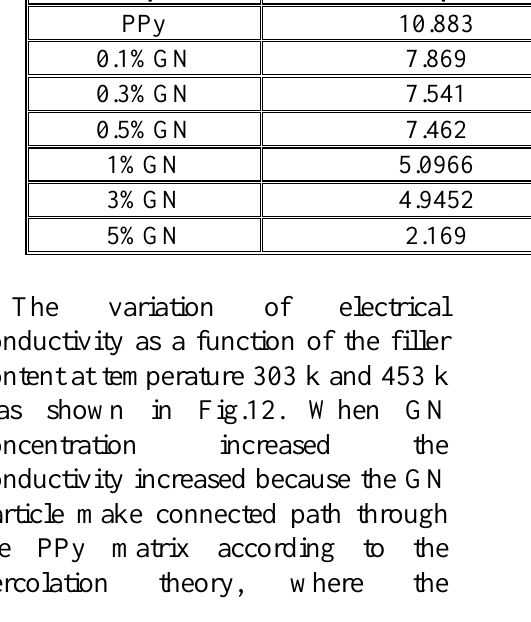
Fig.11: The variation of DC electrical conductivity as a function of reciprocal temperature. Table 2: Activation energy data for all investigated samples. Samples